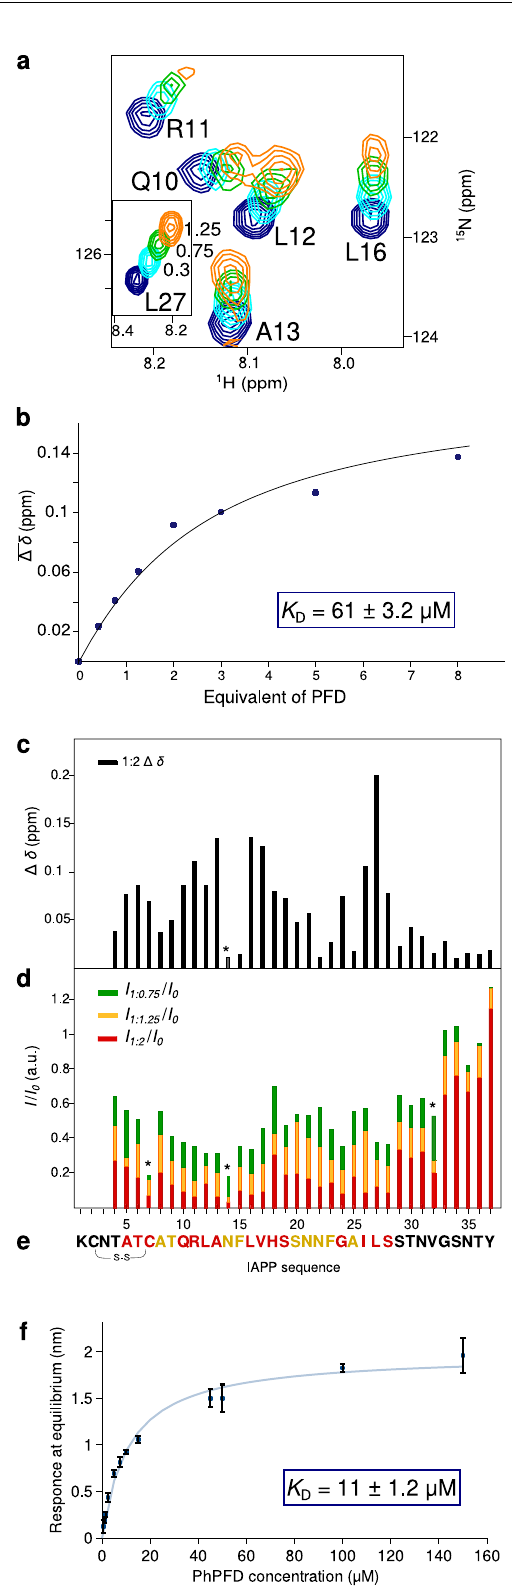
Fig. 3 Interaction of monomeric IAPP with Prefoldin. a Extracts of 2D 15 N- SOFAST-HMQC spectra of IAPP titration by addition of